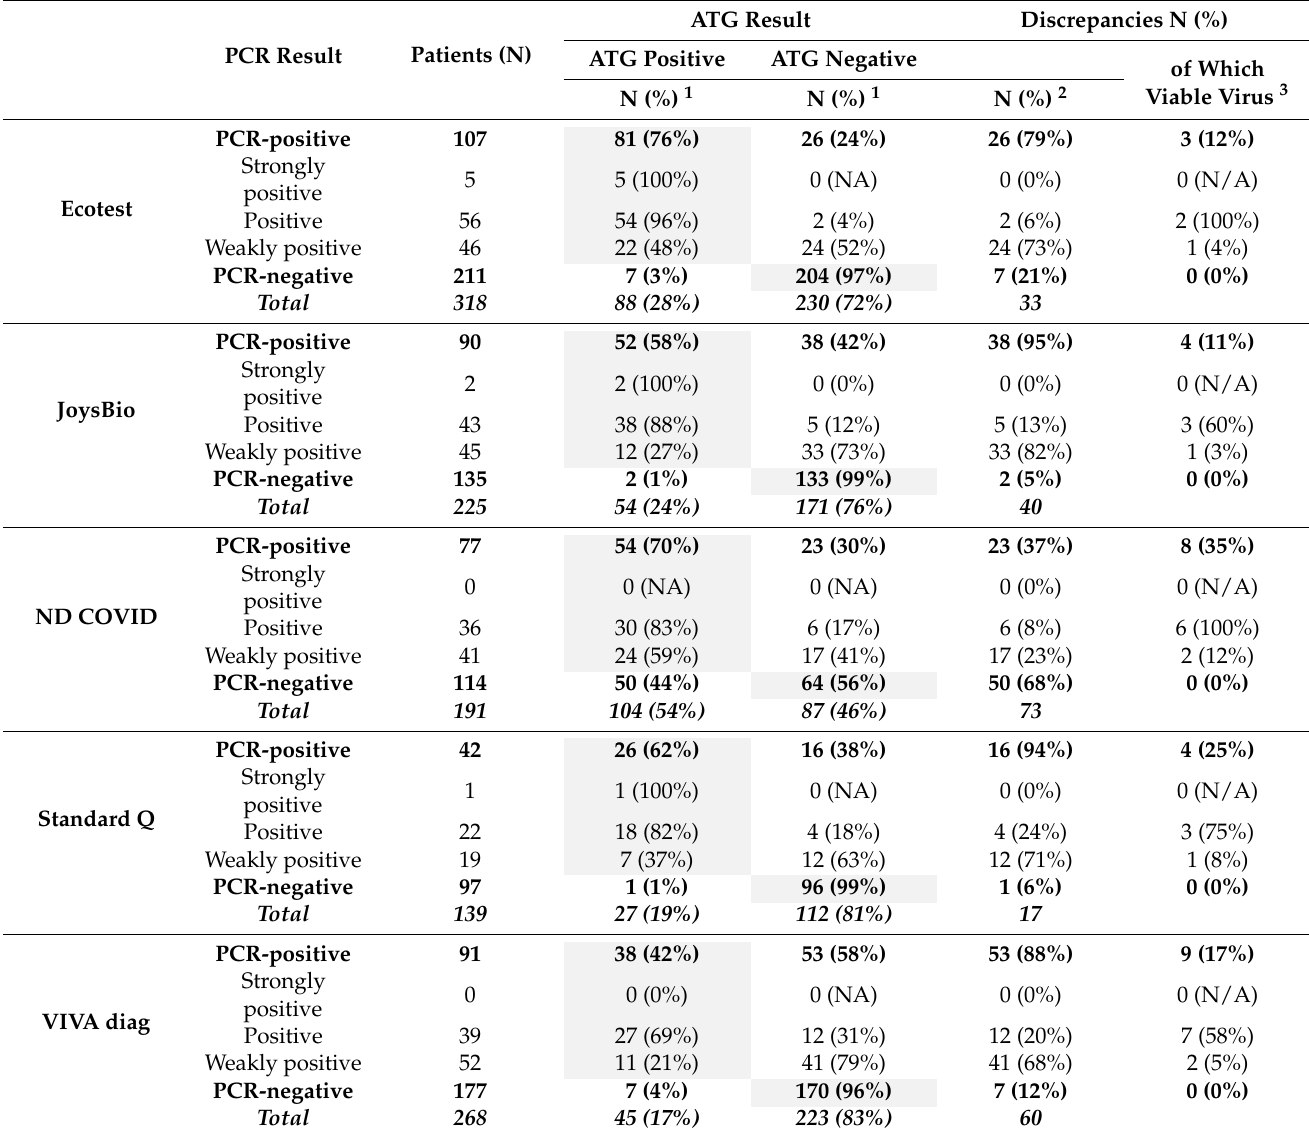
Table A1. Detailed comparison of RT-PCR and antigen test (AGT) for individual tests stratified by cycle threshold (Ct): Strongly positive (Ct ≤ 20), Positive (20 < Ct ≤ 30), Weakly positive (30 < Ct ≤ 40), and Negative (Ct > 40). For better orientation, true positive and true negative values for individual tests are highlighted in